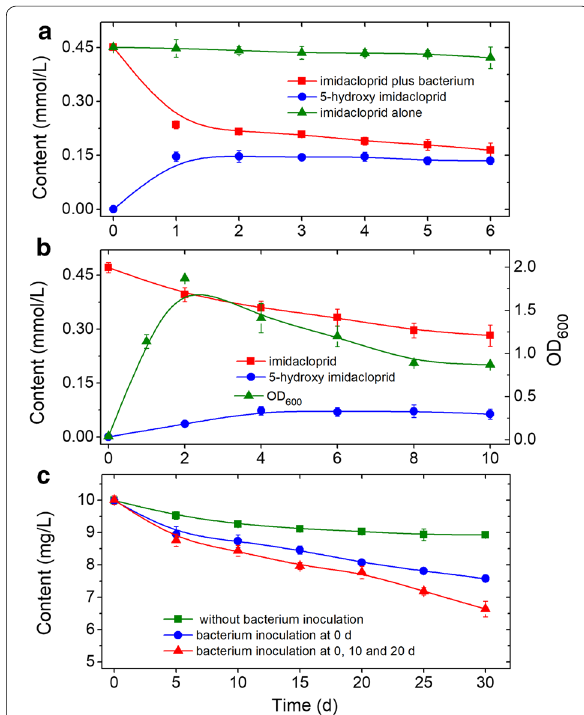
Fig. 5 Time course of imidacloprid degradation by resting cells ( a ), growing culture ( b ), and imidacloprid remediation in tanks containing surface water ( c ). The resting cell transformation broth ( a ) contained 2% maltose as co-substrate and the OD 600 volume of surface water ( c ) was 2.5 L inoculated with 3